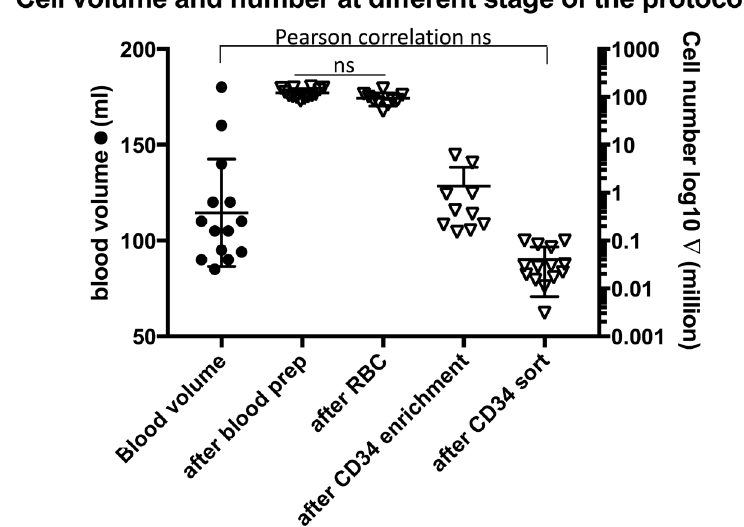
Figure 3. CD34 cells represent a small fraction of PBMCs. Left scale represent the blood volume taken per donors. Paired T-test was used to analyse statistical significance between ‘after blood prep group’ and ‘after red blood cell (RBC) lysis group’ (n=10). Paired Pearson correlation analysis was performed between the blood volume taken and the final number of sorted CD34 cells and no correlation was found (p= 0.115, n=14, Pearson r=0.441).